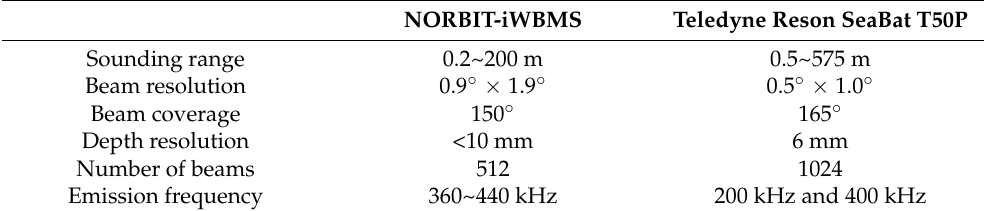
Table 1. Detailed information for the NORBIT-iWBMS and Teledyne Reson SeaBat